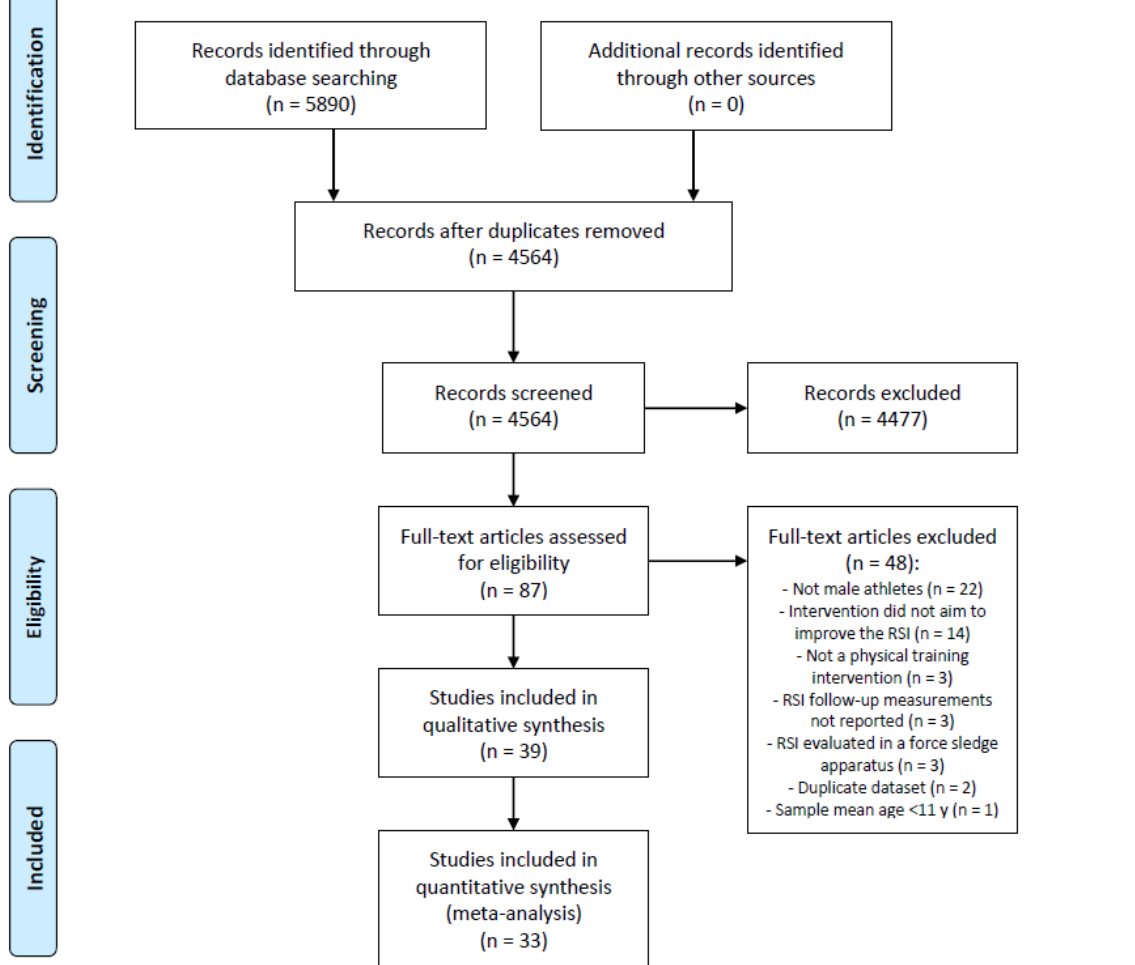
Figure 1. PRISMA statement flow chart. RSI, reactive strength index.